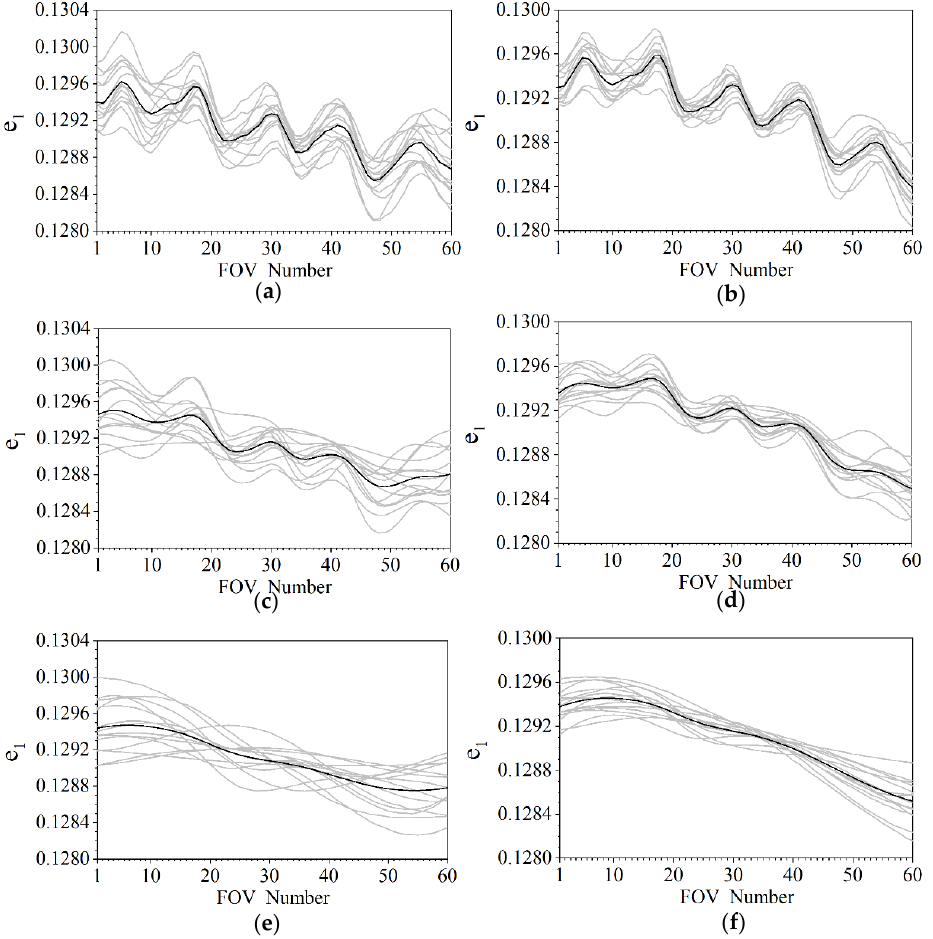
→ e 1 of TB observations at channels 2 (left panels) and 3 (right Figure 8. ( a , b ) The first eigenvector panels) over the 14 swaths (gray curves) on 7 August 2019 after already removing the along-track high-frequency noise (see examples in the second and third panels in Figure 5). ( c , d ) Same as ( a , b ) except for having removed the highest-frequency across-track noise (i.e., the first IMF). ( e , f ) Same as ( a , b ) except for having removed the first two high-frequency across-track noises (i.e., the first and second IMFs). Black curve is the mean of the 14 grey